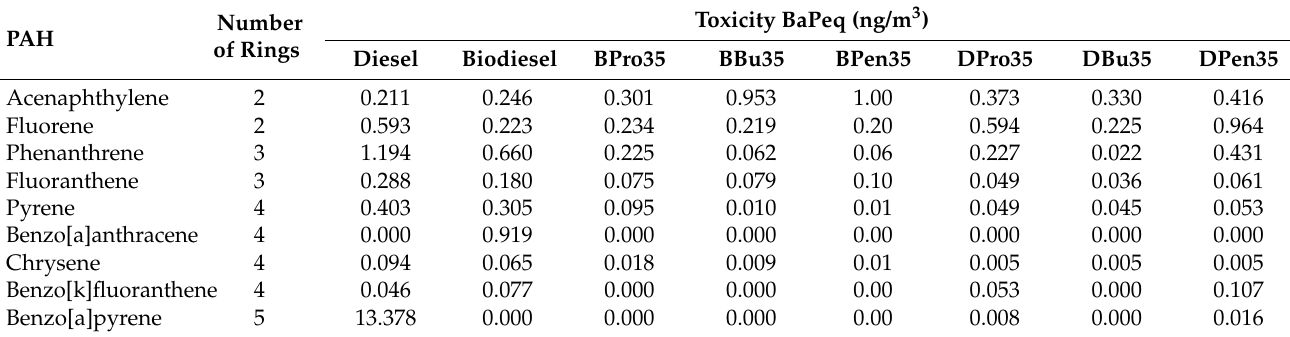
Figure 4. Toxicity of PAH emissions. Table 5. Toxicity BaPeq concentration in